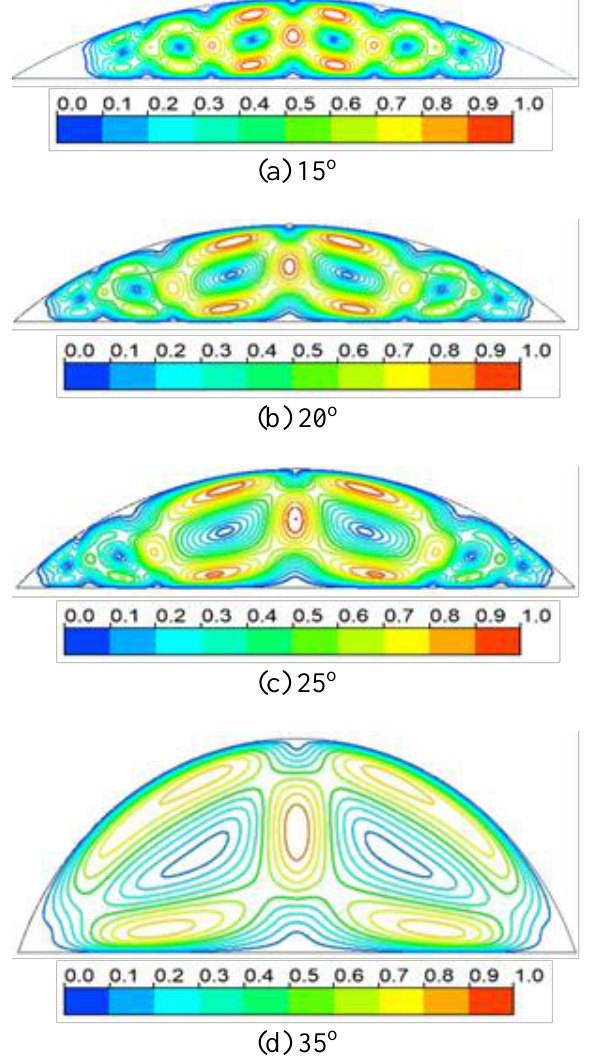
Fig. 4. Velocity contour plot for each